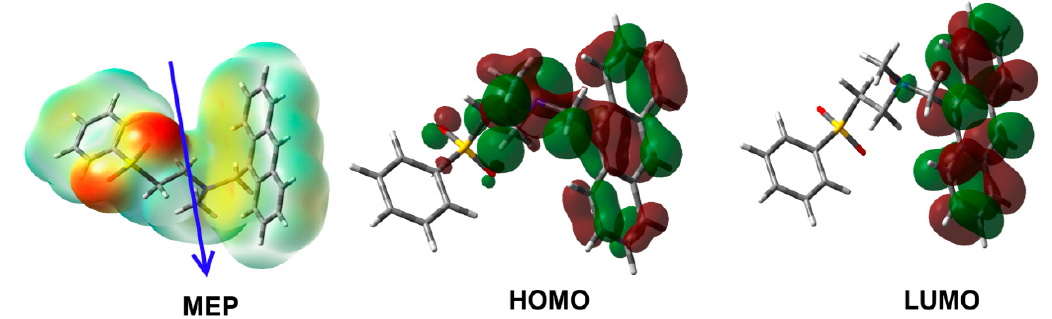
Figure 9. MEP, HOMO and LUMO of aza-Michael product 3.